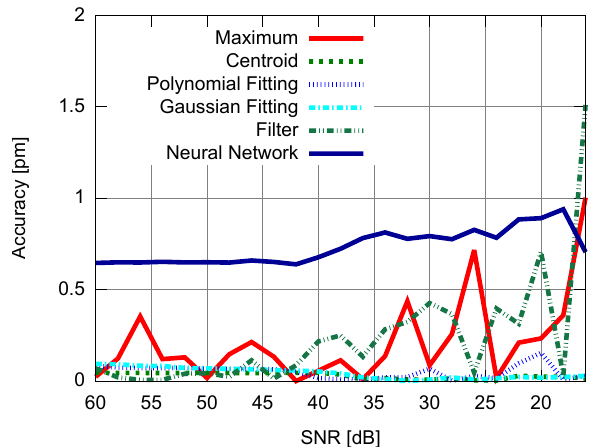
Figure 9. Accuracy for the uniform modulation